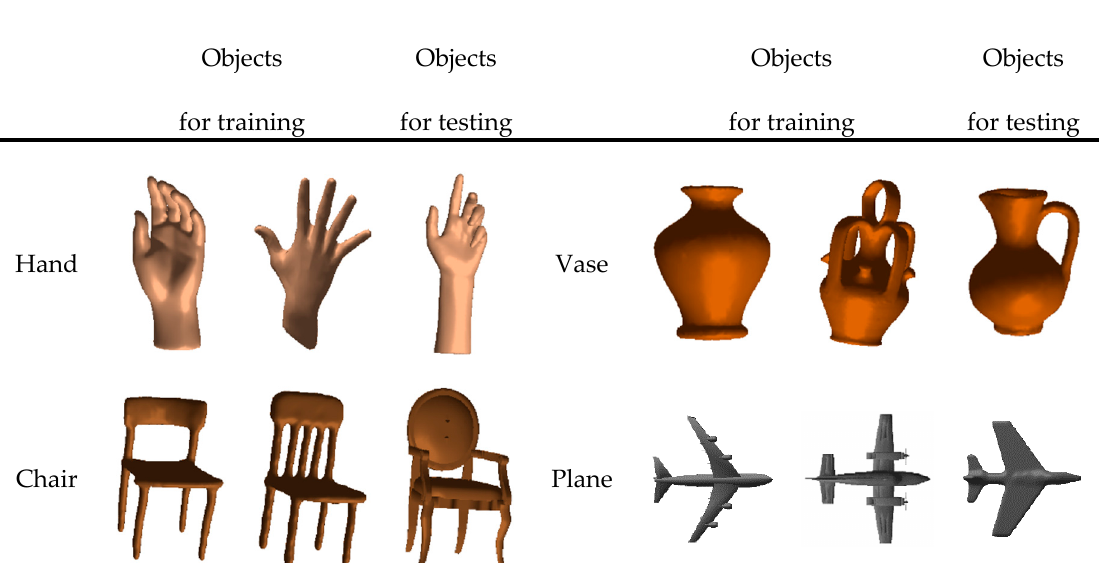
Figure 4. Three-dimensional (3D) models used for training and